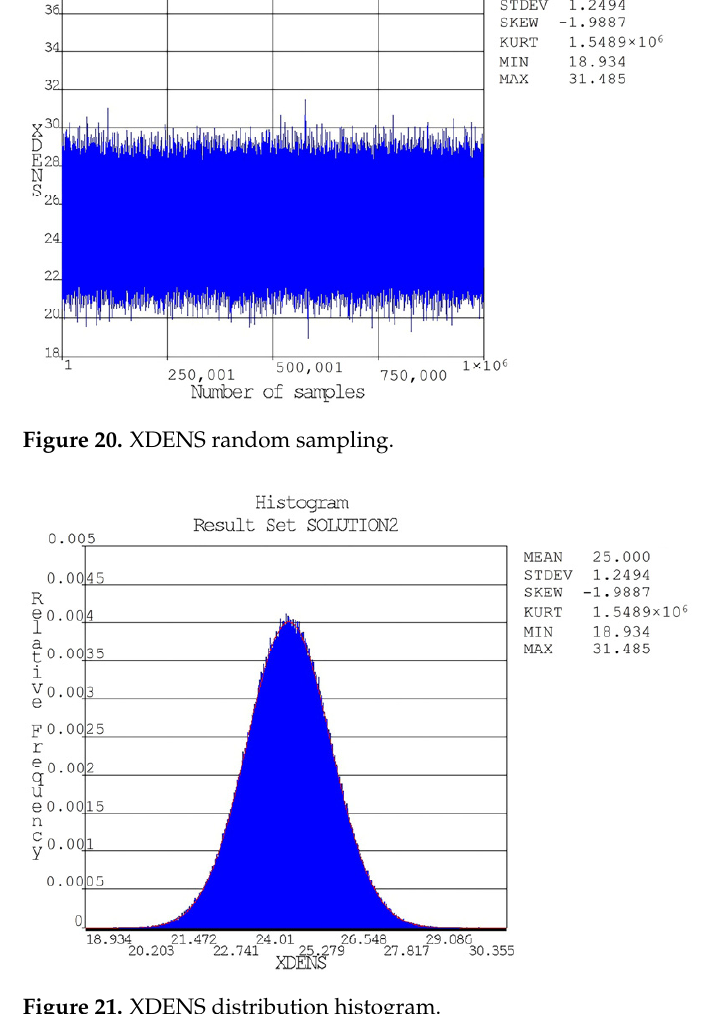
Figure 21. XDENS distribution histogram.